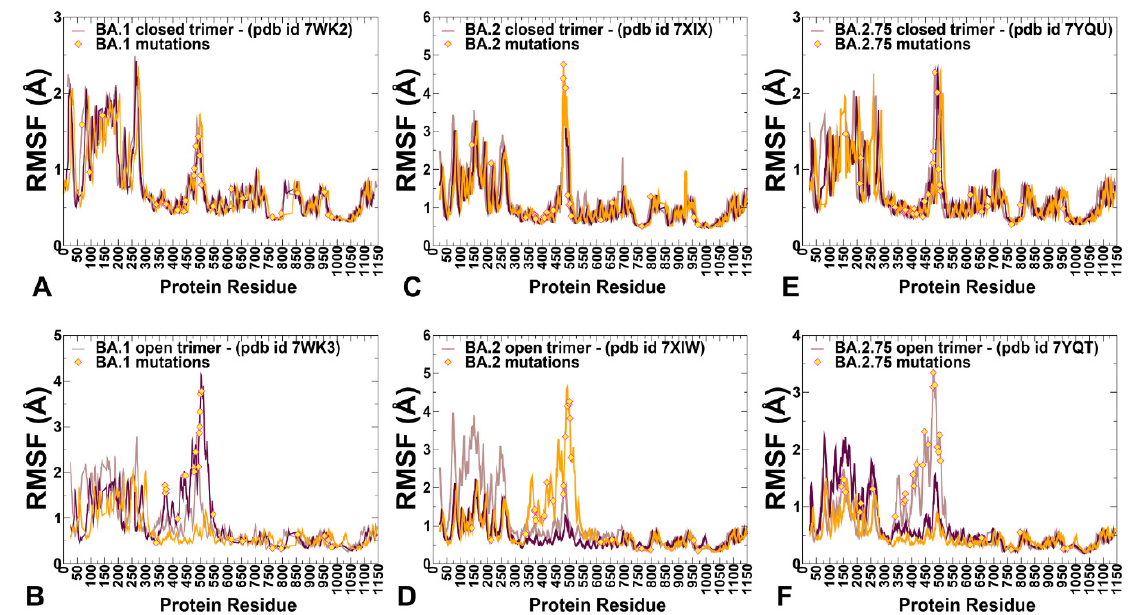
Figure 3. Conformational dynamics profiles of the SARS-CoV-2 S trimers. ( A ) The root mean square fluctuations (RMSF) profiles for the S Omicron BA.1 closed trimer (pdb id 7WK2). The RMSFs for protomer A are in brown lines, protomer B in maroon lines, and protomer C in orange lines. ( B ) The RMSF profiles for the S Omicron BA.1 trimer in the open form (pdb id 7WK3). The 1RBD-up protomer in this structure is protomer A shown in brown lines. The Omicron BA.1 mutations are shown in yellow-filled diamonds. ( C ) The RMSF profiles for the SARS-CoV-2 S Omicron BA.2 closed trimer (pdb id 7XIX). The RMSFs for protomer A are in brown lines, protomer B in maroon-colored lines, and protomer C in orange lines. ( D ) The RMSF profiles for the S Omicron BA.2 trimer in the open form (pdb id 7XIW). The 1RBD-up protomer in this structure is protomer C shown in orange lines. The Omicron BA.2 mutations are in yellow- fi lled diamonds. ( E ) The RMSF pro fi les for the SARS-CoV-2 S Omicron BA.2.75 closed trimer (pdb id 7YQU). The RMSFs for protomer A are in brown lines, protomer B in maroon-colored lines, and protomer C in orange lines. ( F ) The RMSF pro fi les for the S Omicron BA.2.75 trimer in the open form (pdb id 7YQT). The 1RBD-up protomer in this structure is protomer A shown in brown lines. The positions of the Omicron BA.2.75 mutations are shown in yellow- fi lled diamonds.